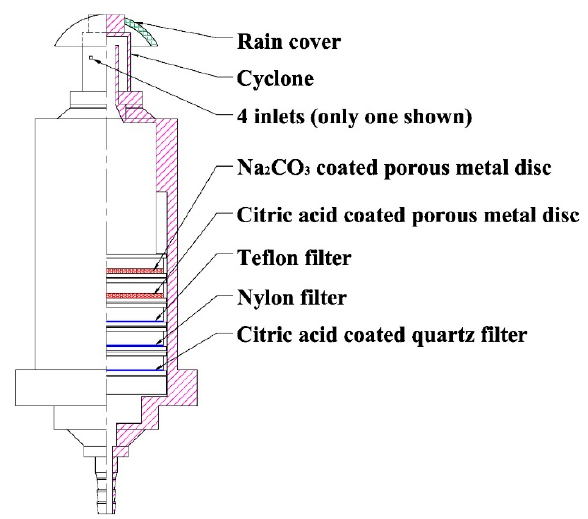
Figure 1. Schematic diagram of the 5 L/min porous-metal denuder sampler (PDS).